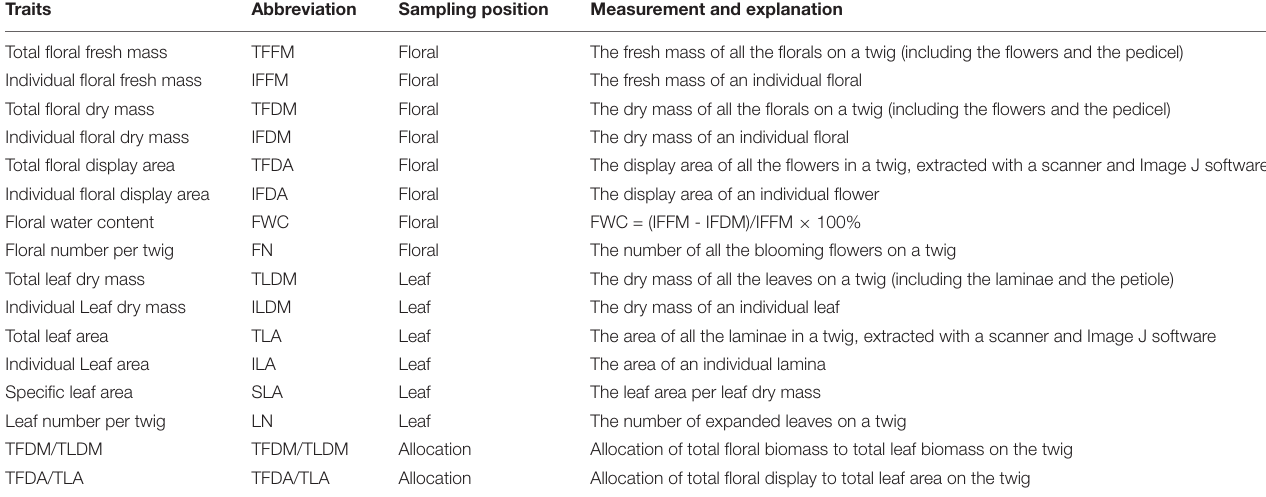
TABLE 1 | Traits and measurement of florals and leaves. Traits